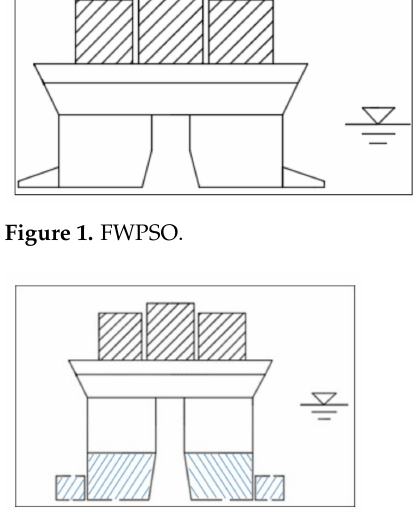
Figure 2. FCDS with an